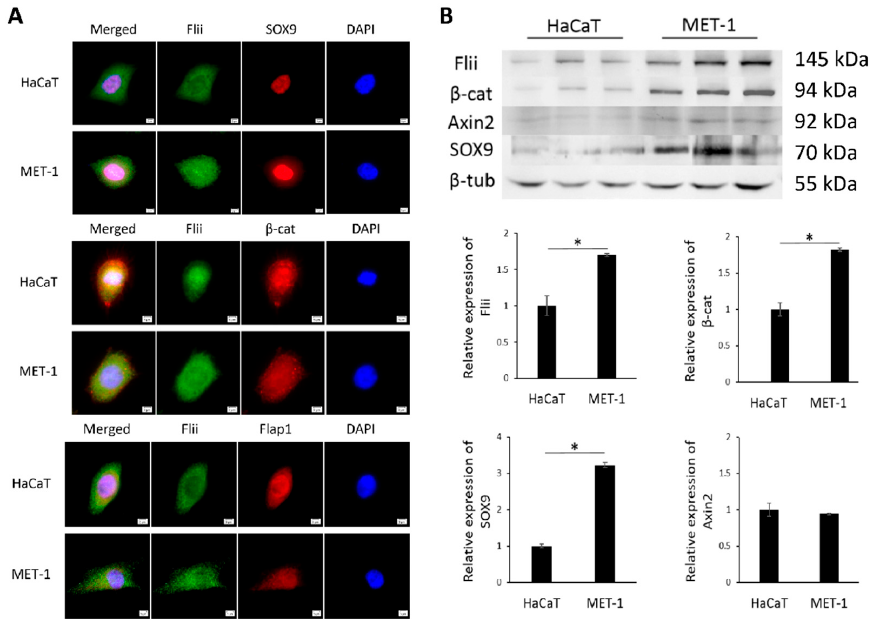
Figure 1. Flii is increased in human late stage metastatic cSCC cell line and colocalizes with Wnt/ β - catenin signaling pathway molecules. ( A ) Dual immunocytochemistry of Flii (green) and SOX9, β -catenin ( β -cat) and Flap1 (red) in HaCaT and MET-1 cells. Nuclear DAPI staining shown as pseudo-stained blue. Scale bars, 5 µ m. ( B ) Western blot analysis of Flii, β -catenin, Axin2,